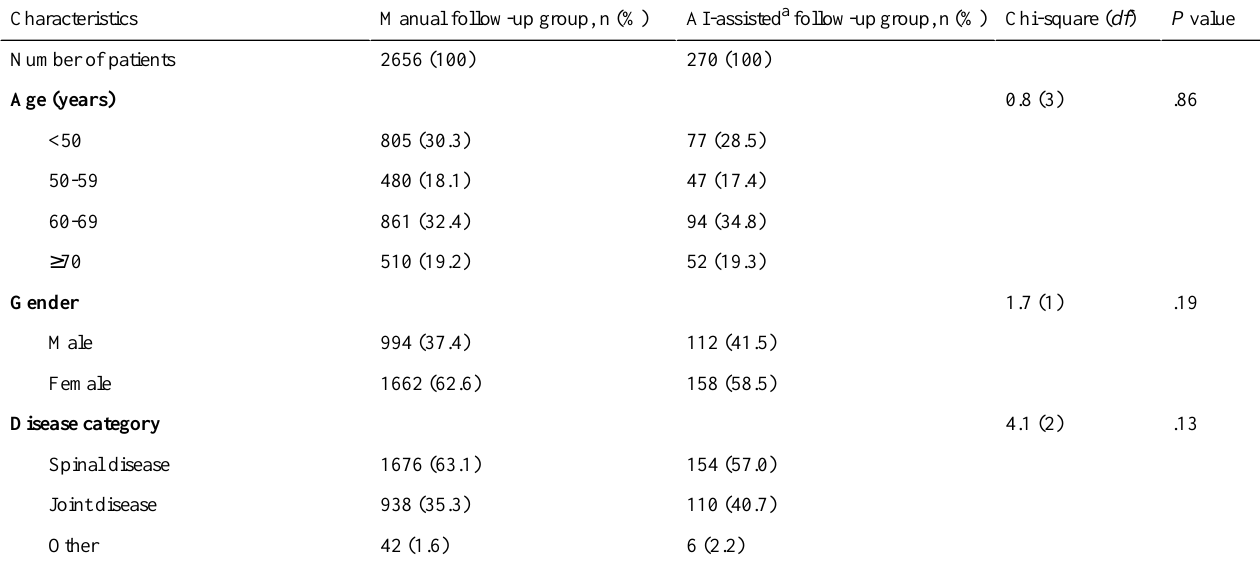
Table 2. Comparison of patient characteristics in manual and artificial intelligence–assisted follow-up groups.